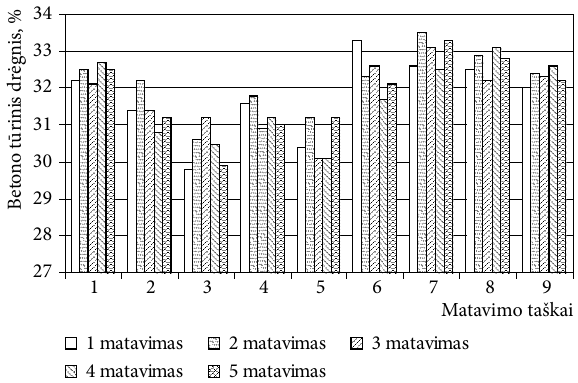
Fig. 3. The spread of moisture measuring results at nine points of a distinct cube